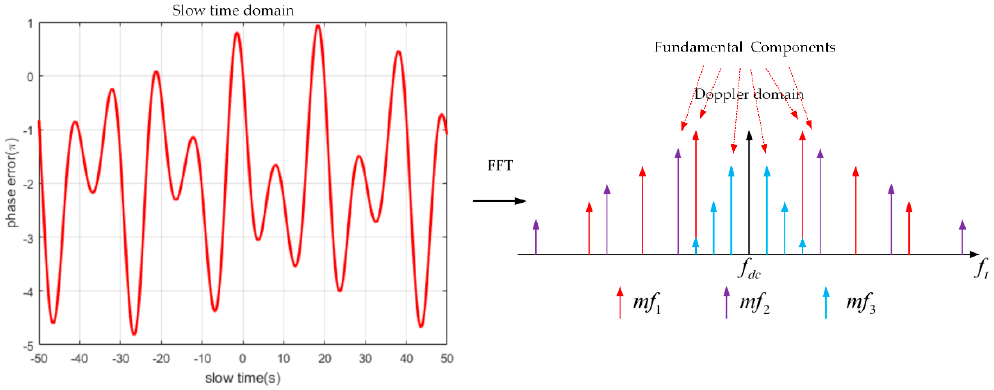
Figure 4. The signal focused at sinusoidal function frequencies in the RD domain.